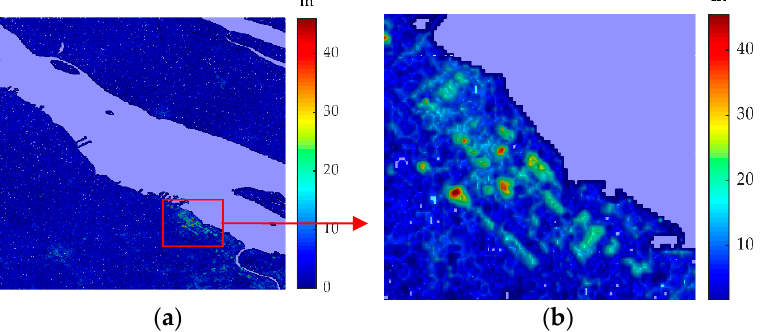
Figure 11. DEM data of Shanghai, where the red box area is the region of interest (ROI). ( a ) DEM data, ( b ) DEM of the ROI.